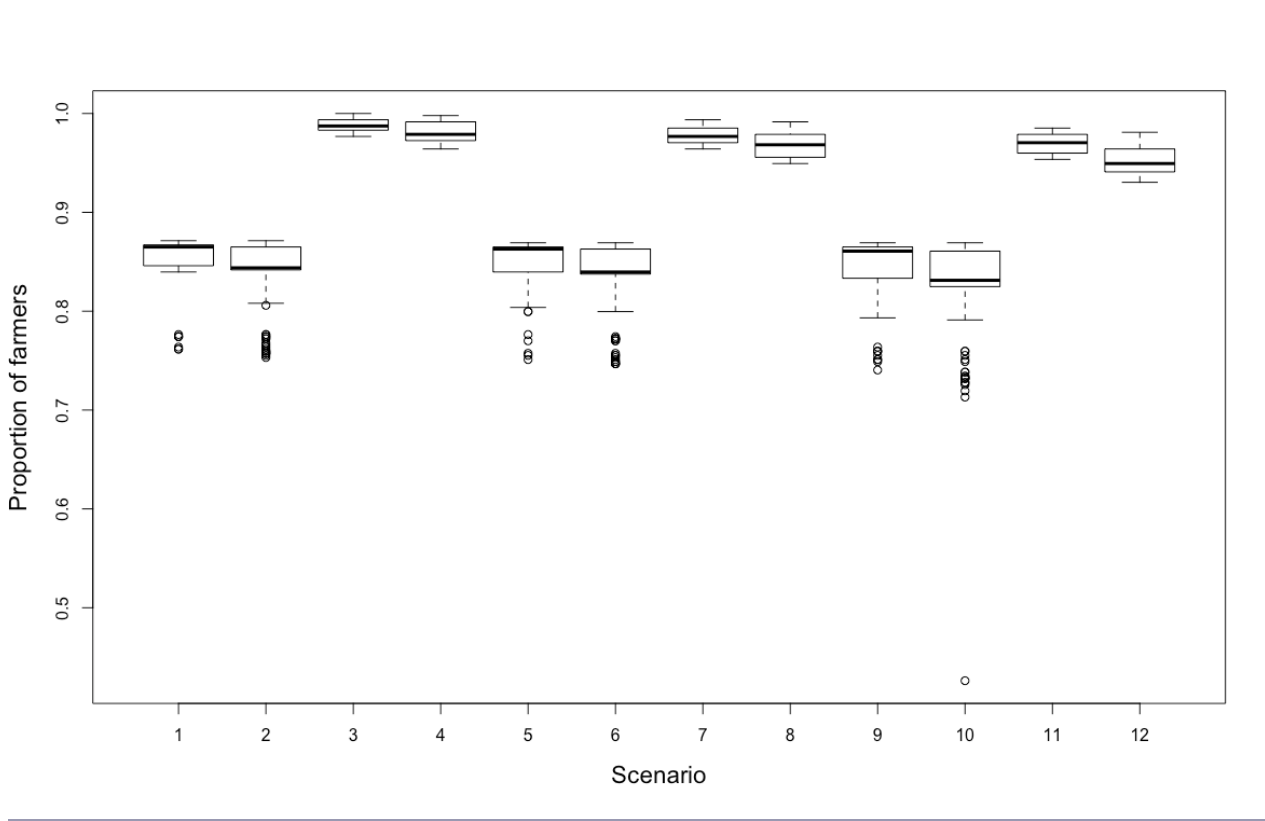
Fig. 5 . Distributions of the proportions of farmers who are resilient to perturbations (remaining in business at the end of the simulation) by scenario. Farmers in the scenarios affected by the baseline perturbation regime (S1, S5, and S8) are generally more resilient than those (S2, S6, and S10) affected by the alternative (and greater) perturbation regime. The relative lower sensitivity of switchgrass to simulated droughts results in a greater number of resilient farmers in those scenarios (S3, S4, S7, S8, S11, and S12). Each scenario was simulated 1000